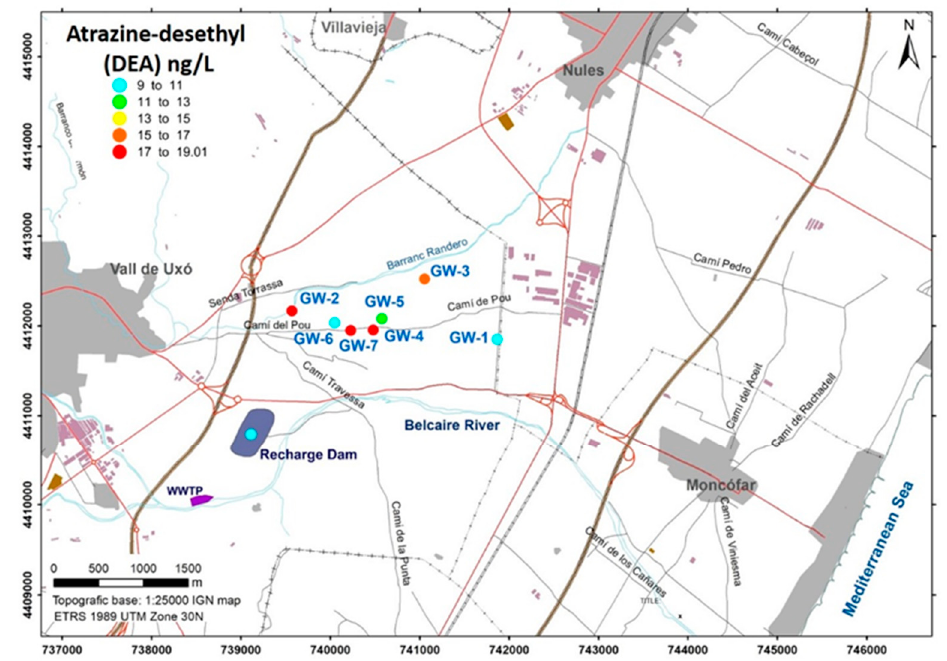
Figure 6. The location map of GW samples and the detected maximum concentrations of DEA (desethyl atrazine) (ng/L).